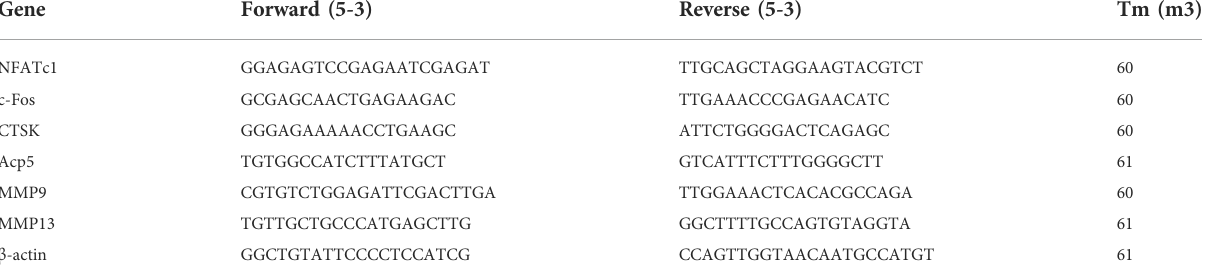
TABLE 1 Primers for